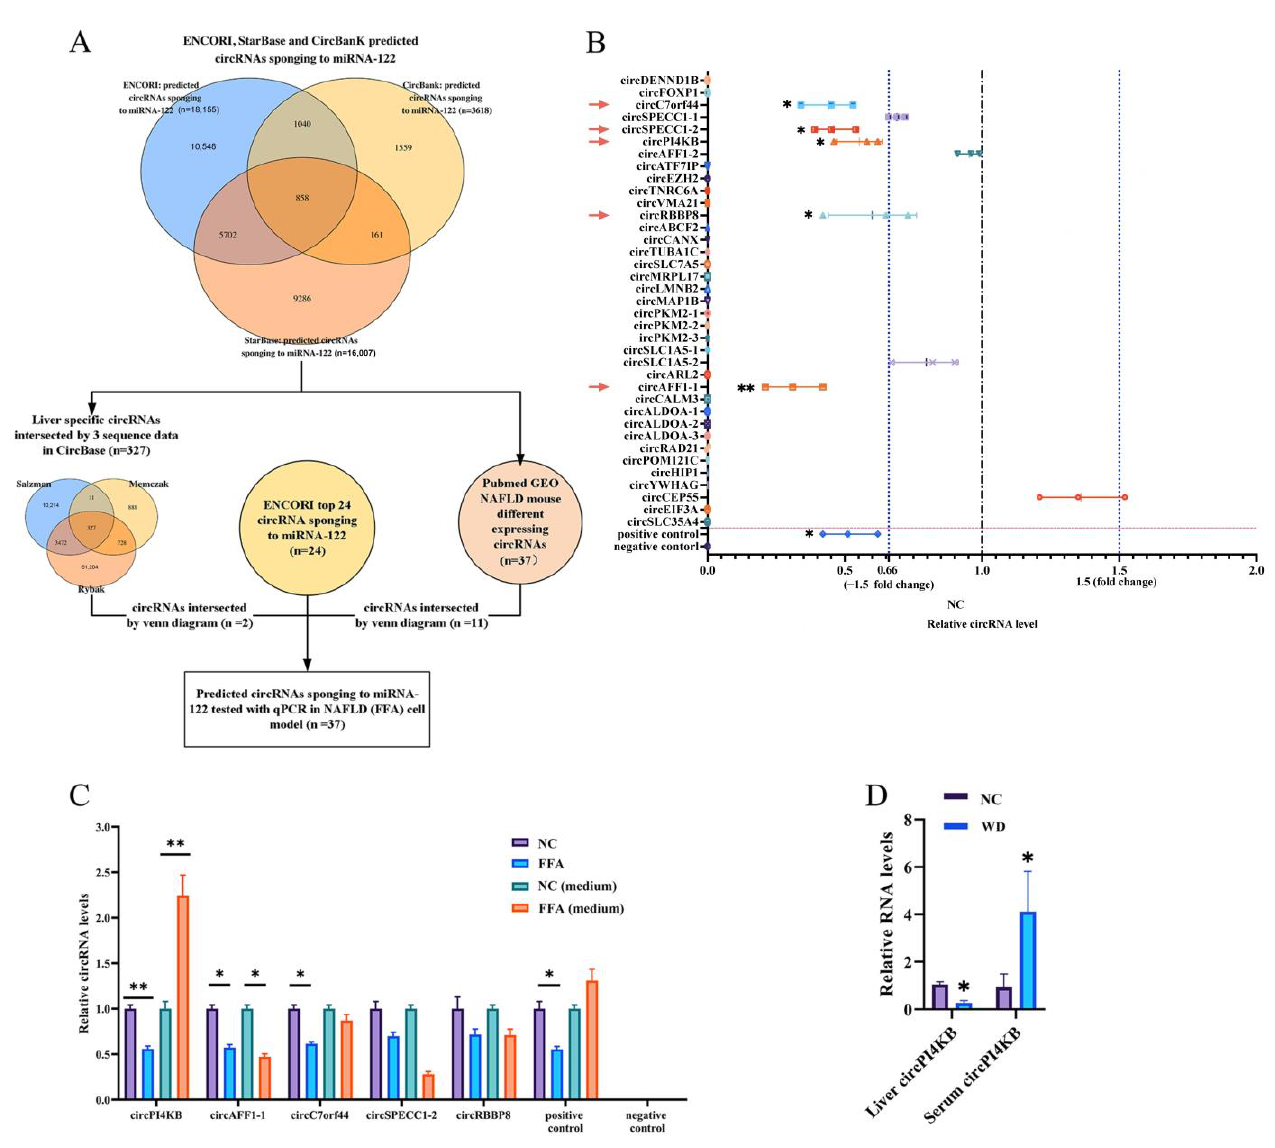
Figure 2. The circPI4KB was decreased in hepatocytes and was increased in extra-hepatocyte. ( A ) Flowchart of prediction of specific circRNAs sponging to miRNA-122. The ENCORI, StarBase, and Circbank databases were used to predict the circRNAs sponging to miRNA-122. The predictive circRNAs were further intersected with 1) liver-specific circRNAs (down left) and GEO NAFLD mouse profile (down right) (Circbase of Memczak mouse 1903 circRNA intersected with 1686 differentially expressed circRNA in GSE134146 dataset of NAFLD model). Finally, 37 predicted circRNAs were identified that sponge to miRNA-122 and were predicted to be possibly dysregulated in NAFLD. ( B ) RT-qPCR analysis of the 37 predicted miRNA-122-sponging circRNAs were validated in the FFA-induced NAFLD cell model. ( C ) RT-qPCR analysis of the expression level of 5 dysregulated circRNAs in normal control cell (NC cell) and culture medium (NC medium), and FFA-induced NAFLD cell (FFA cell) and culture medium (FFA medium), ( n = 3). ( D ) RT-qPCR analysis of the expression level of circPI4KB in liver tissue and serum of WD-induced NAFLD (WD) and control mice (NC), ( n = 6). (* p < 0.05; ** p <